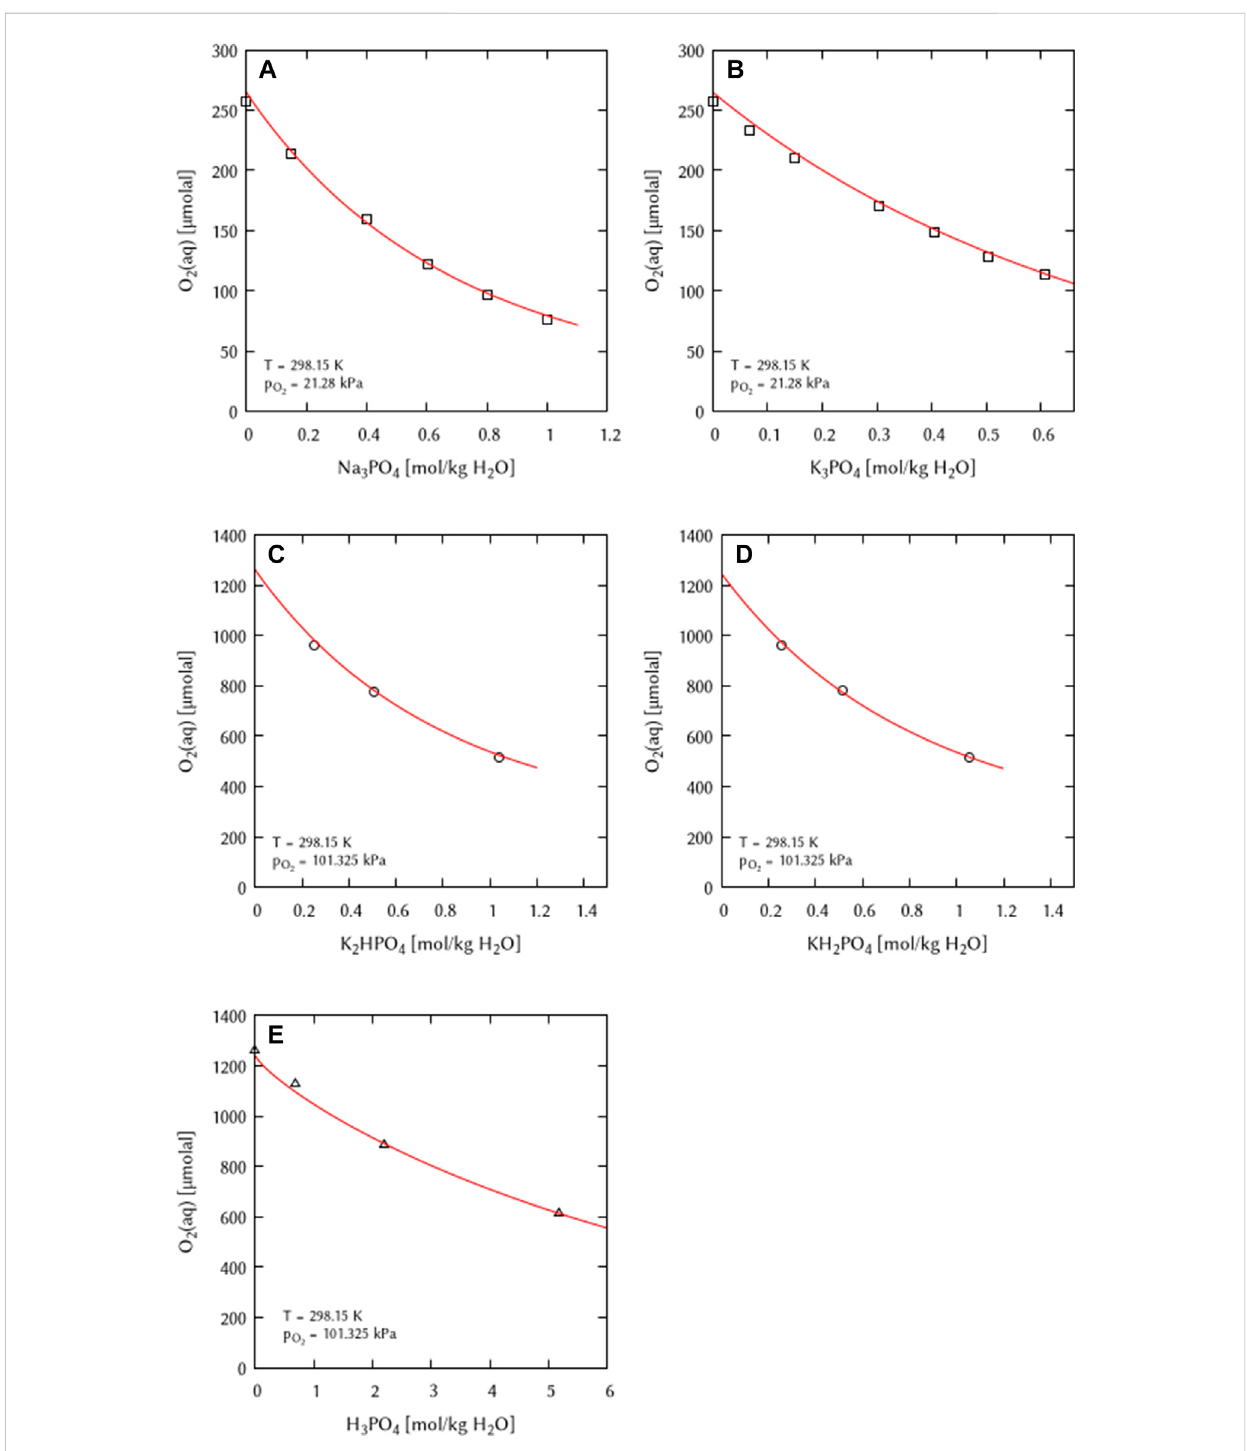
FIGURE 7 ModellingoftheO 2 solubilityinbinarysolutionsof (A) Na 3 PO 4 , (B) K 3 PO 4 , (C) K 2 HPO 4 , (D) KH 2 PO 4 ,and (E) H 3 PO 4 asafunctionofelectrolyteconcentrationat T = 298.15 K (Points: Experimental data from □ Khomutov and Konnik (1974), ○ Iwai et al. (1993), n Gubbins and Walker (1965), Lines: this